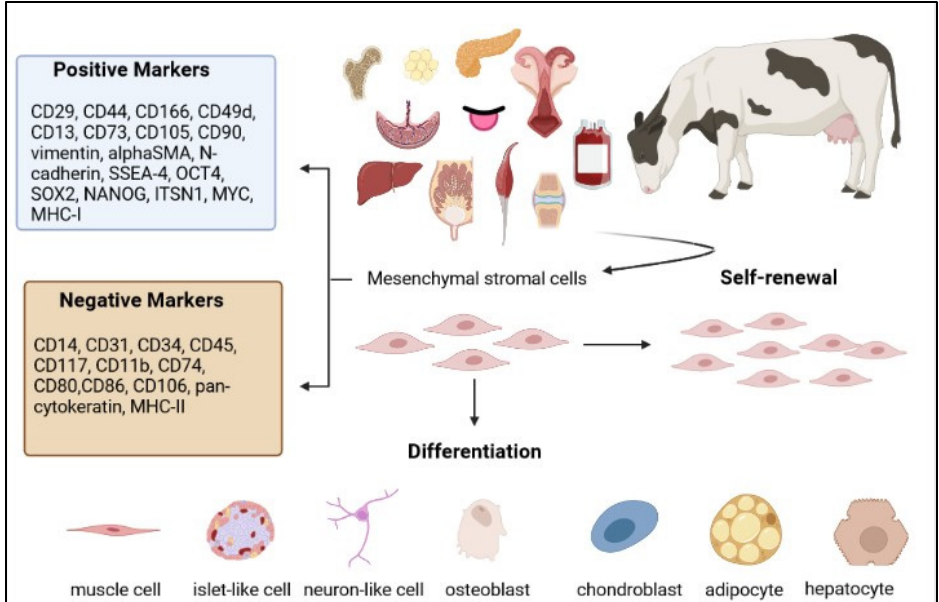
Figure 1. Schematic diagram of the characteristics of bovine mesenchymal stromal cells (created in Biorender.com, accessed on 14 July 2022).